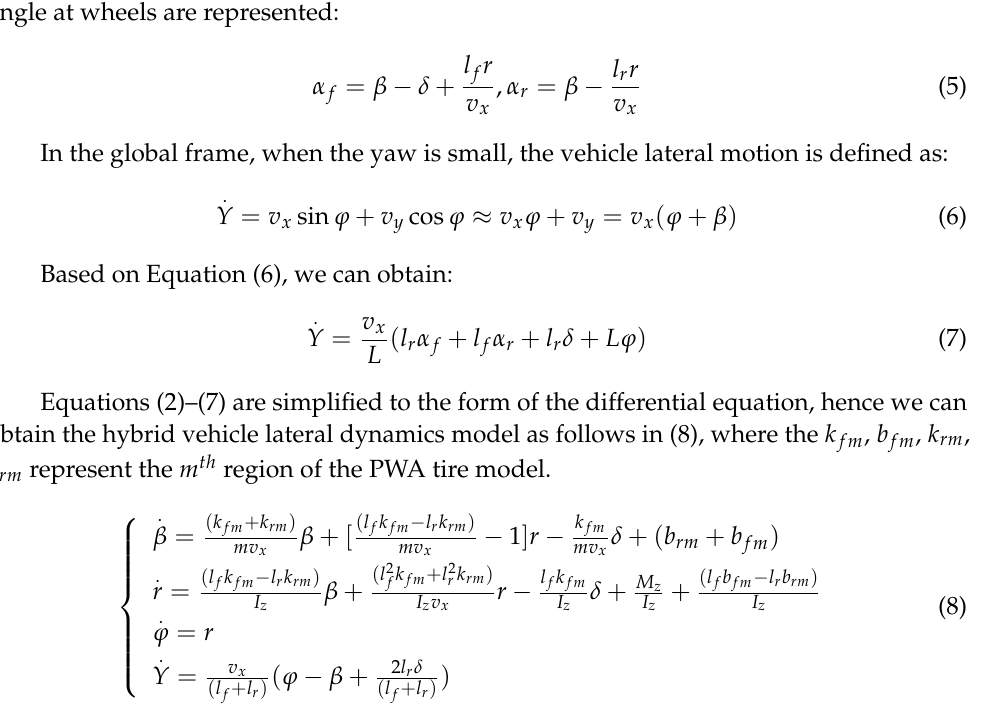
v of the four-wheel y α r